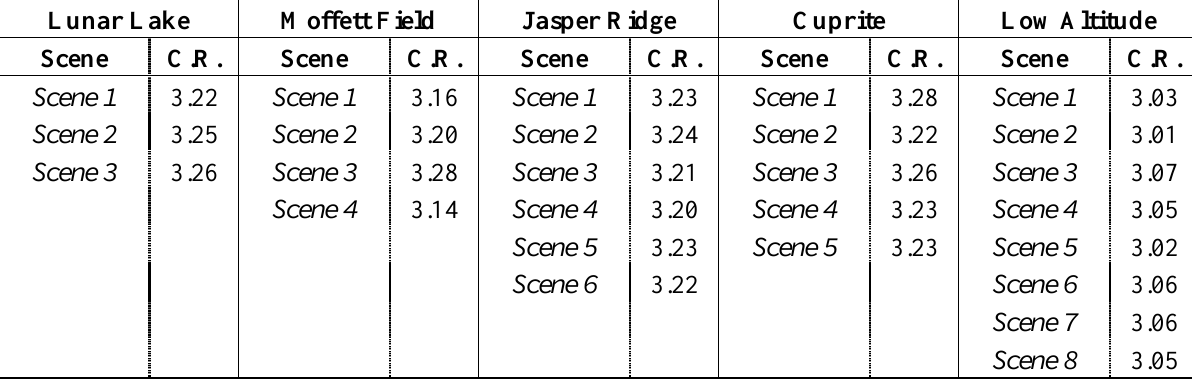
Table 2. Results (C.R. achieved for each scene of the hyperspectral imagery with Pearson’s correlation-based band ordering).